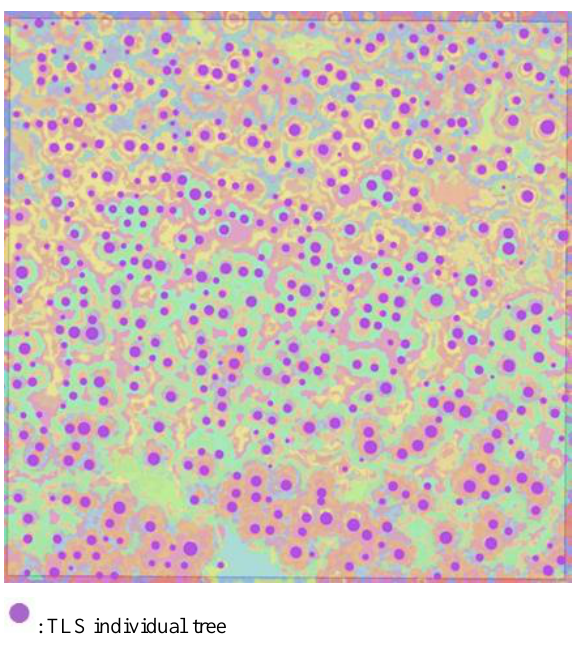
Figure 2. Map of trees within the plot created using a combination of data collected by TLS and drone use The TLS scanner has its own Global Positioning System (GPS) sensor; however, its error is large in dense forest. The accuracy of the drone GPS measurement is typically high due to good satellite signal reception. We performed geometric correction of TLS so that the tree locations determined by TLS fit those determined by the drone. Manual geometric correction was made first and the distance and the angle geometric correction were estimated. The estimations of the distance and the angle geometric correction were used for extra data input such as TLS scanner locations. To visualize the tree heights obtained by the drone, we applied random colour classification to the drone DSM data according to height (Figure 2). Because the tree locations determined by TLS were based on the trunk locations and the tree locations of the drone data were based on the tree tops, some tree locations did not match exactly between the two datasets. The distance and the angle geometric corrections for the TLS data were 10.3 m and – 12.8°, respectively.